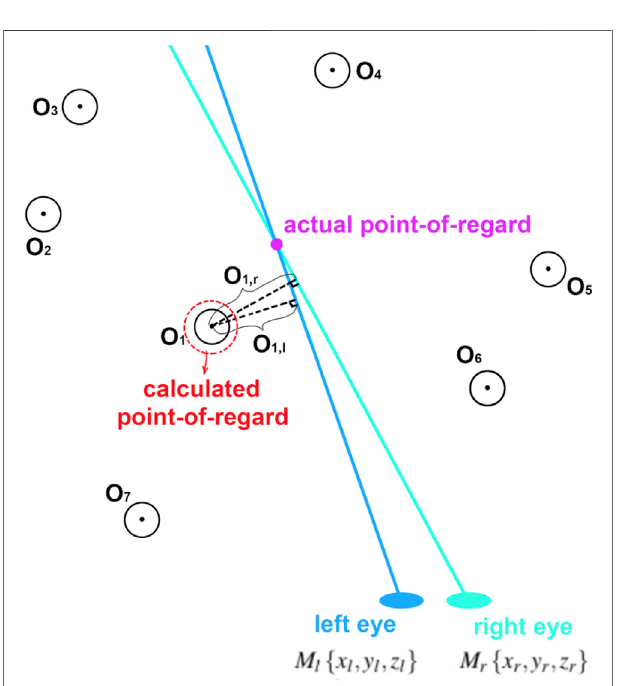
FIGURE 2 | Schematic of the closest target approximation method.